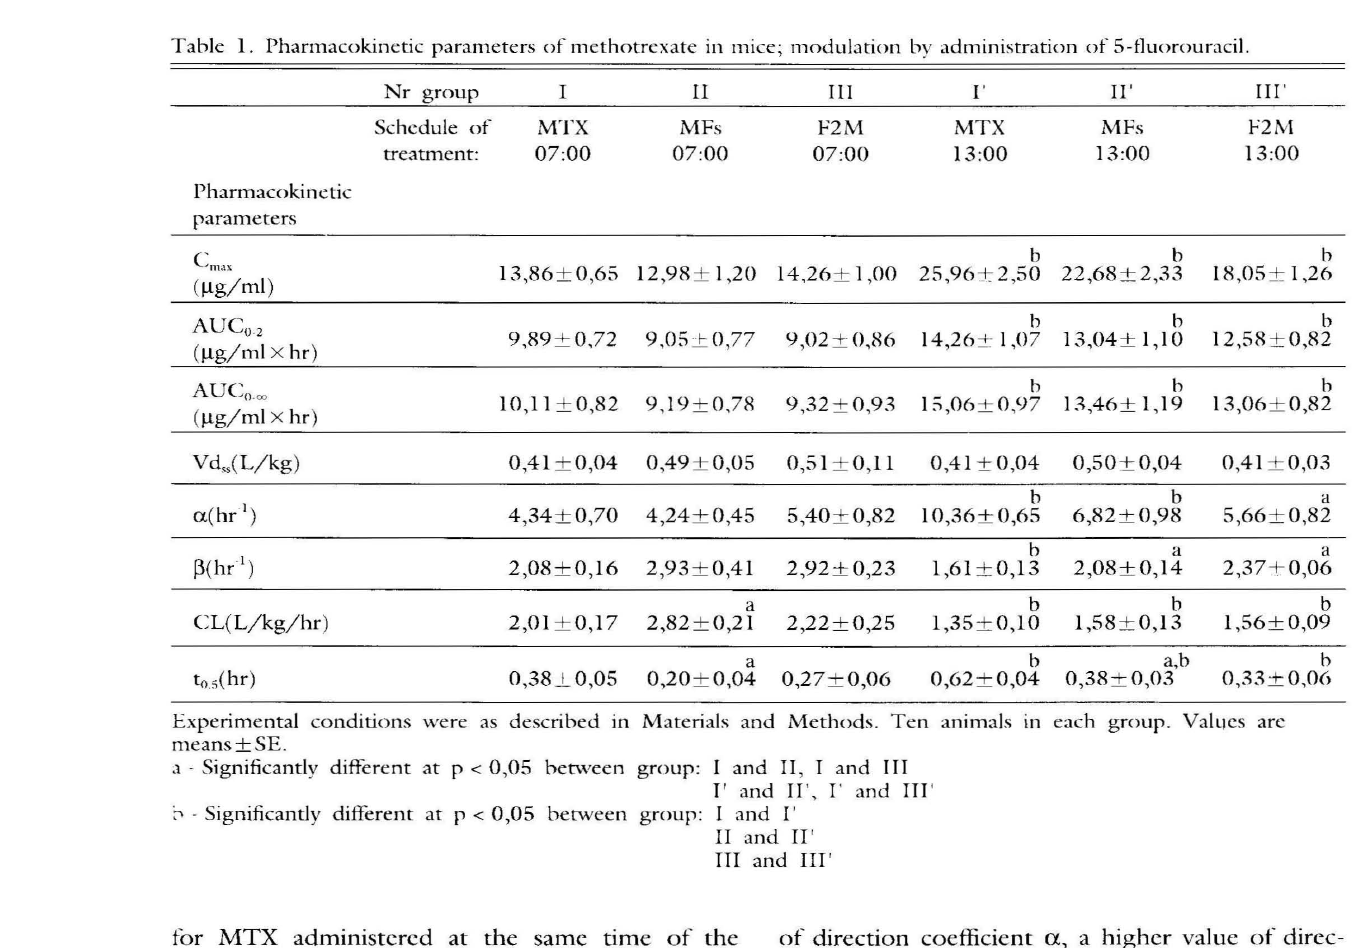
Table I. Pharmacokinetic parameters of methotrexate in mice; modulation by administration of 5-tluorouracil. Nr